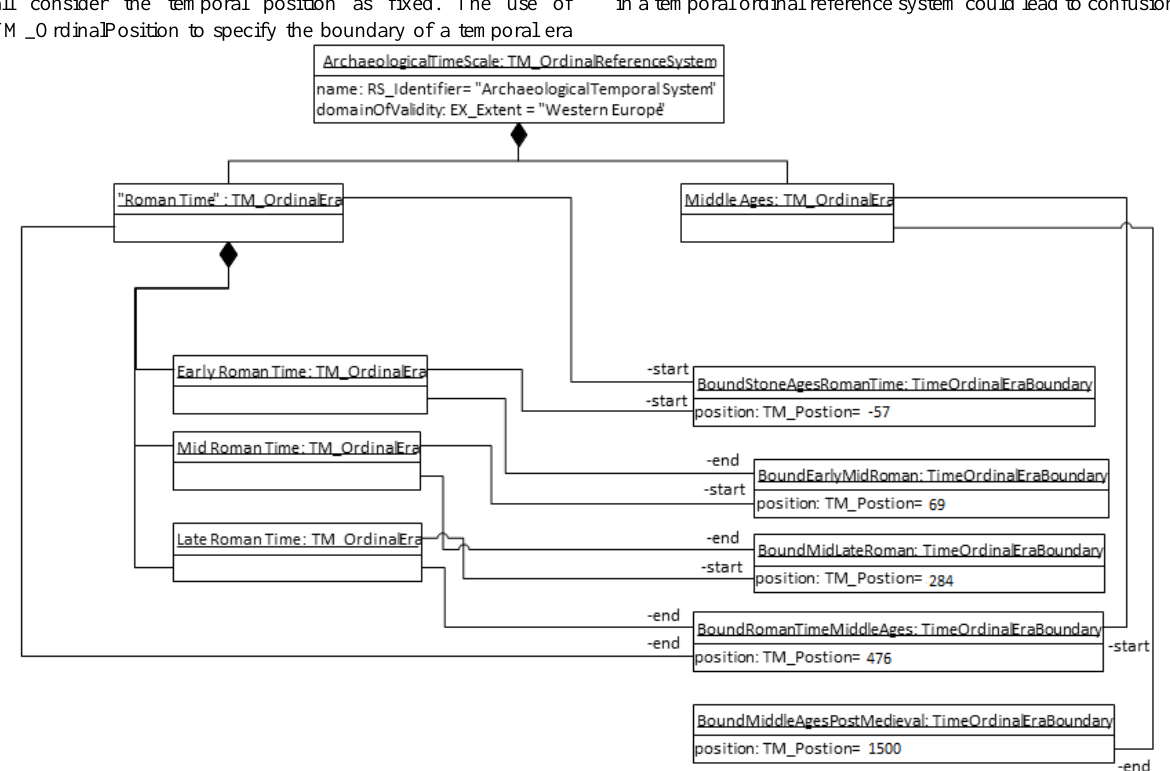
Figure 9 Archaeological time scale as temporal ordinal reference system according to the model of Cox and Richard